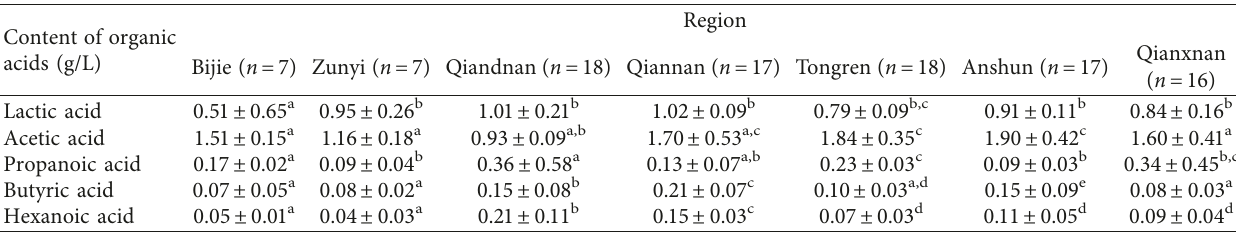
a,b,c,d Means in the same row with different superscript letters are statistically significantly different according to one-way ANOVA ( p < 0 . 05); these values indicate δ 13 C acetic acid values that are responsible for sauce-flavor baijiu from different regions. Table 2: The mean ± standard error value content of five organic acids of sauce-flavor baijiu from seven different origins (unit: mg/L). Content of organic acids (g/L)